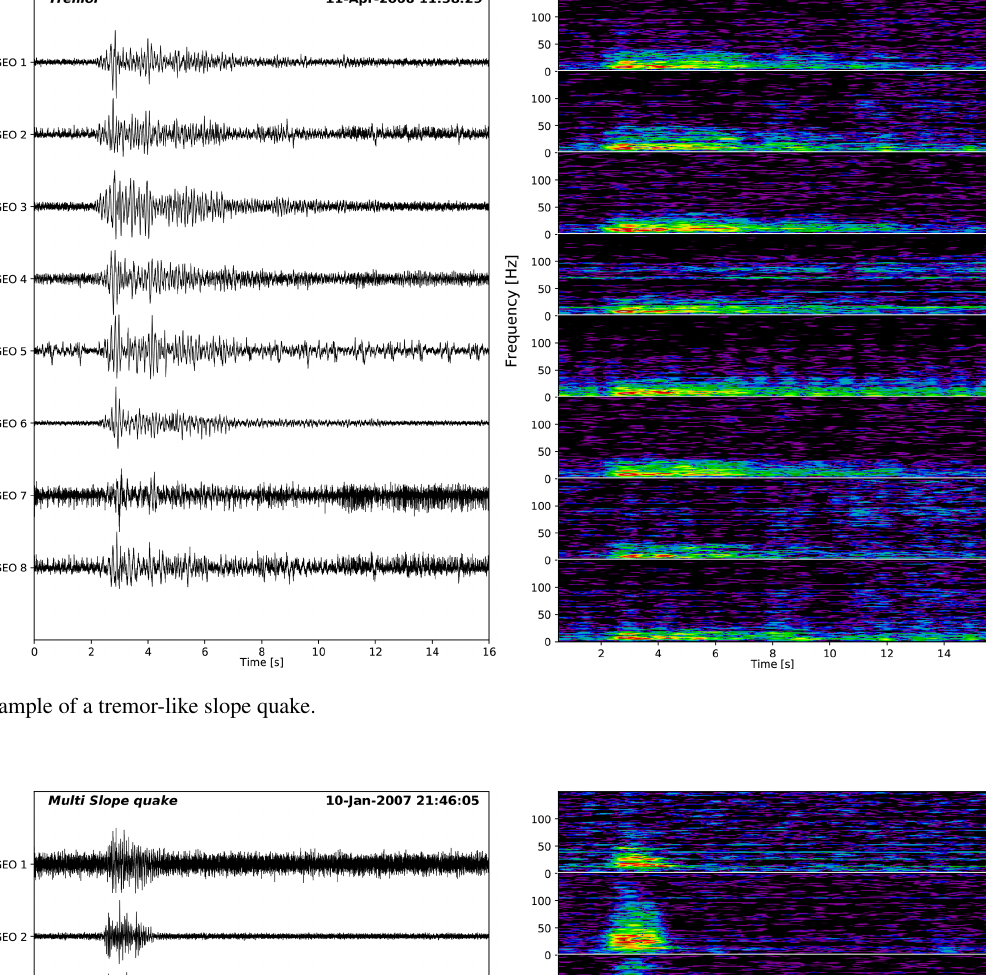
Figure B3. Example of a tremor-like slope quake.